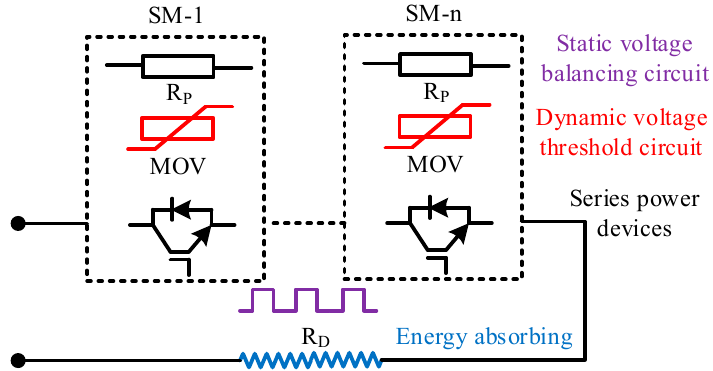
Figure 9. MOV based modular solid-state switches and a concentrated resistor (MC-DCC) topology [32].